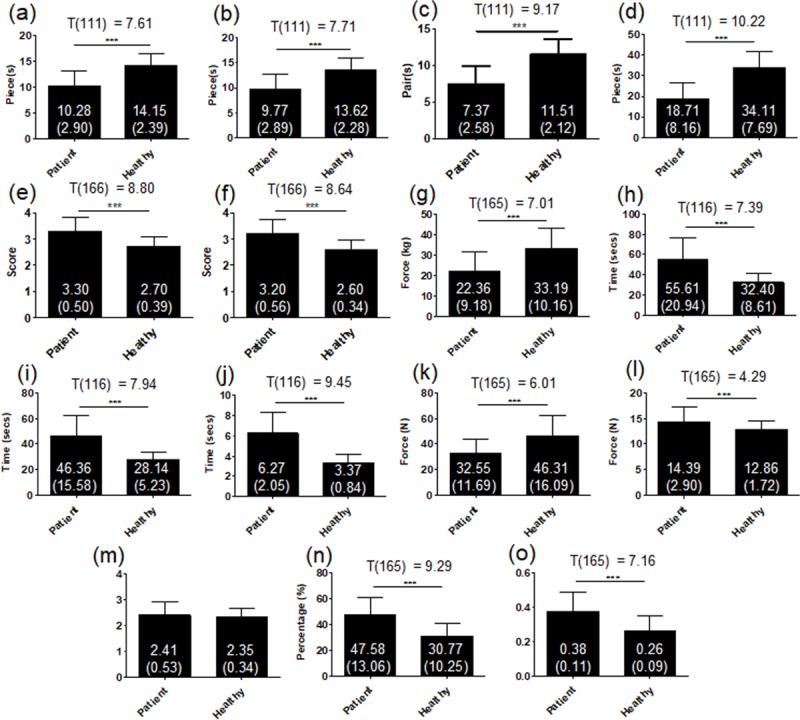
Overall comparison different hand function tests between the patients and the healthy.***p < .001. Bars are plotted with mean and standard deviation. Each subgraph represents the following: Purdue Pegboard test: (A) dominant hand, (B) non-dominant hand, (C) both hands and (D) assembly; SWM test: (E) thumb and (F) little finger; (G) Grip force; MTT: (H) roughness, (I) shape and (J) weight subtest; PHUA parameters: (K) Static FPPeak, (L) FPPeak, (M) FR, (N) % Static FPPeak and (O) FRNorm.